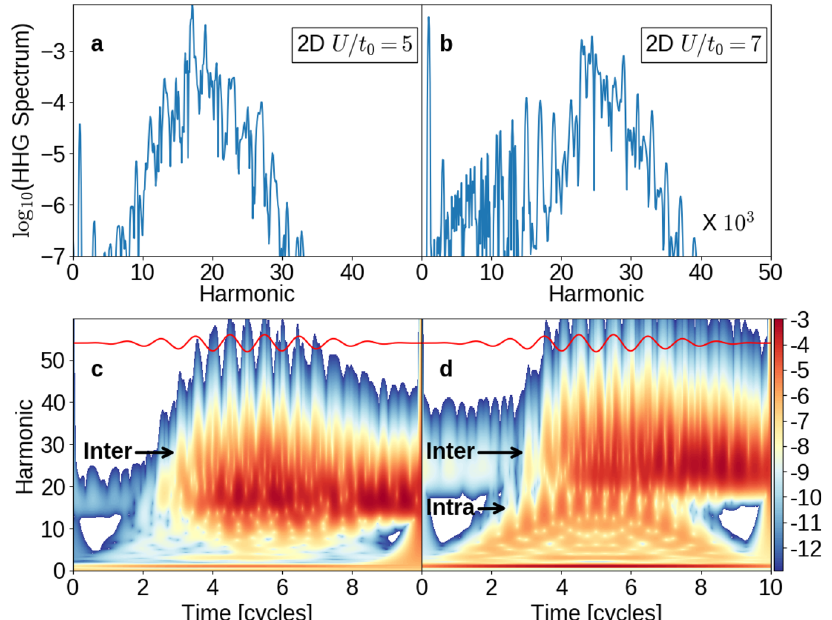
Fig. 5 HHG in the effective single-particle model. Time-averaged and time-resolved HHG in 2D, describing interaction strengths U / t 0 = 5 ( a , c ) and U / t 0 = 7 ( b , d ) (multiplied by 10 3 ), corresponding to optimized values of V = 2.1 and V = 3.1, respectively. The U / t 0 = 7 spectrogram shows a splitting of the emission into two sectors according to its origin in intra- or inter-band processes, with these emission bands labelled on the